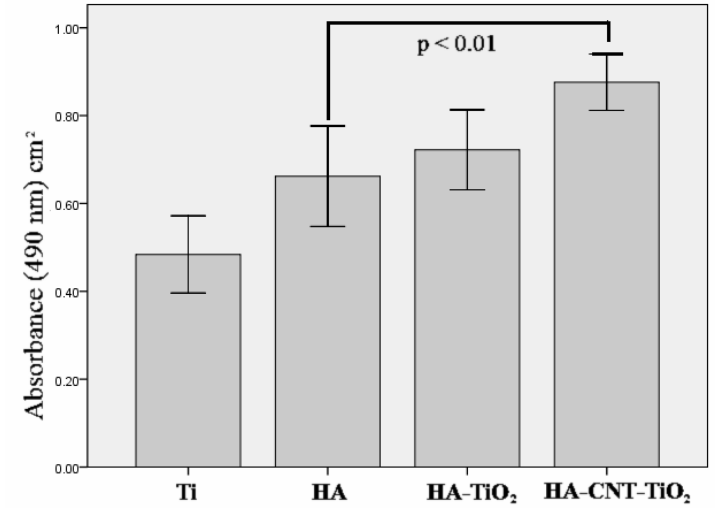
Figure 9. Proliferation of MC3T3-E1 cells cultured on each sample for 5 d. Bare Ti substrate was used as a